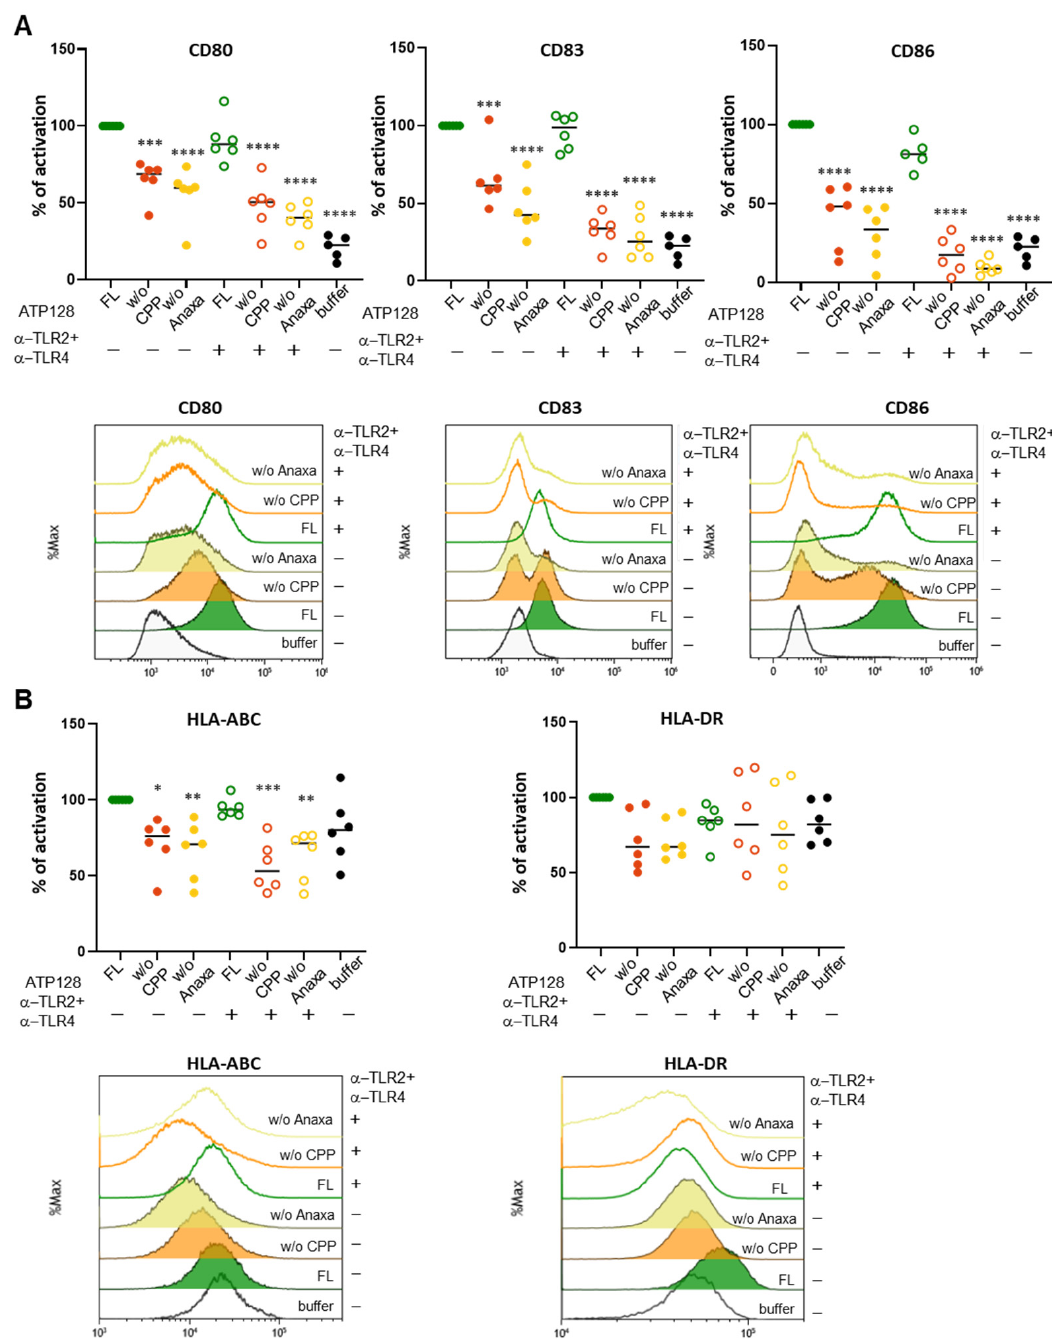
Figure 7. Both CPP and Anaxa are essential for human moDC activation. ( A ) Human moDC were pre-treated with a combination of anti-TLR2 and anti-TLR4 for 1 h, then stimulated for 24 h with 300 nM ATP128 FL, ATP128 w / o CPP, or ATP128 w / o Anaxa. Cells were collected after stimulation and surface costimulatory molecules ( A ) and HLA class I and class II molecules ( B ) were analyzed through flow cytometry. Each shape is representative of a different buffy coat. Histograms of one representative buffy coat are shown below. Values were compared via one-way ANOVA test to the sample stimulated with ATP128 FL. **** p -value < 0.0001, *** p -value < 0.001, ** p -value < 0.01, * p -value < 0.05.